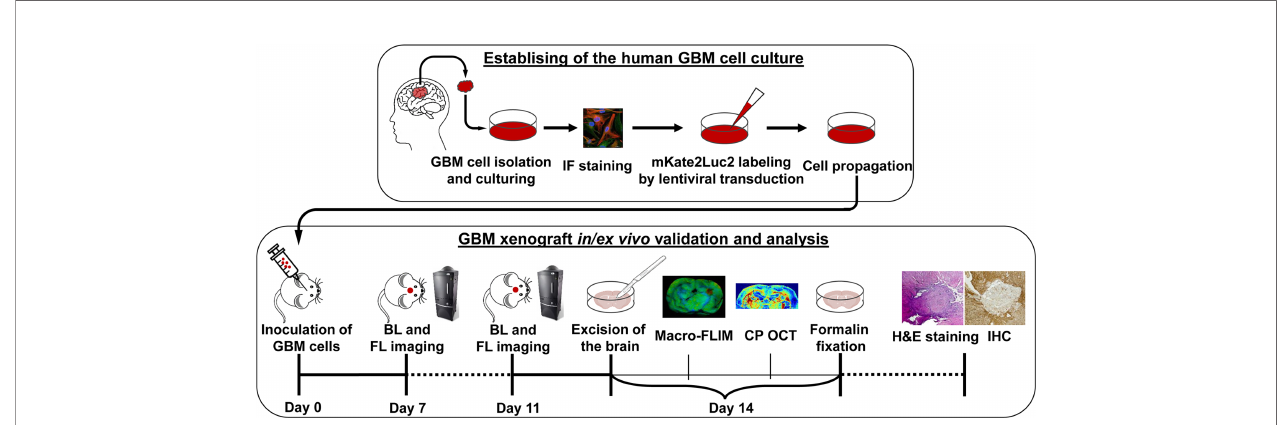
FIGURE 1 | Design of the experiment. Establishing of the cell culture from the human tissue sample of GMB included isolation from the freshly resected brain tumor specimen, immuno fl uorescence (IF) staining, lentiviral transduction for dual labeling, cell culturing, and propagation. Validation and analysis of GBM7-Luc2-mKate2 xenograft included in vivo bioluminescence (BL) and fl uorescence (FL) imaging, ex vivo macro-FLIM, CP OCT, histological evaluation, and